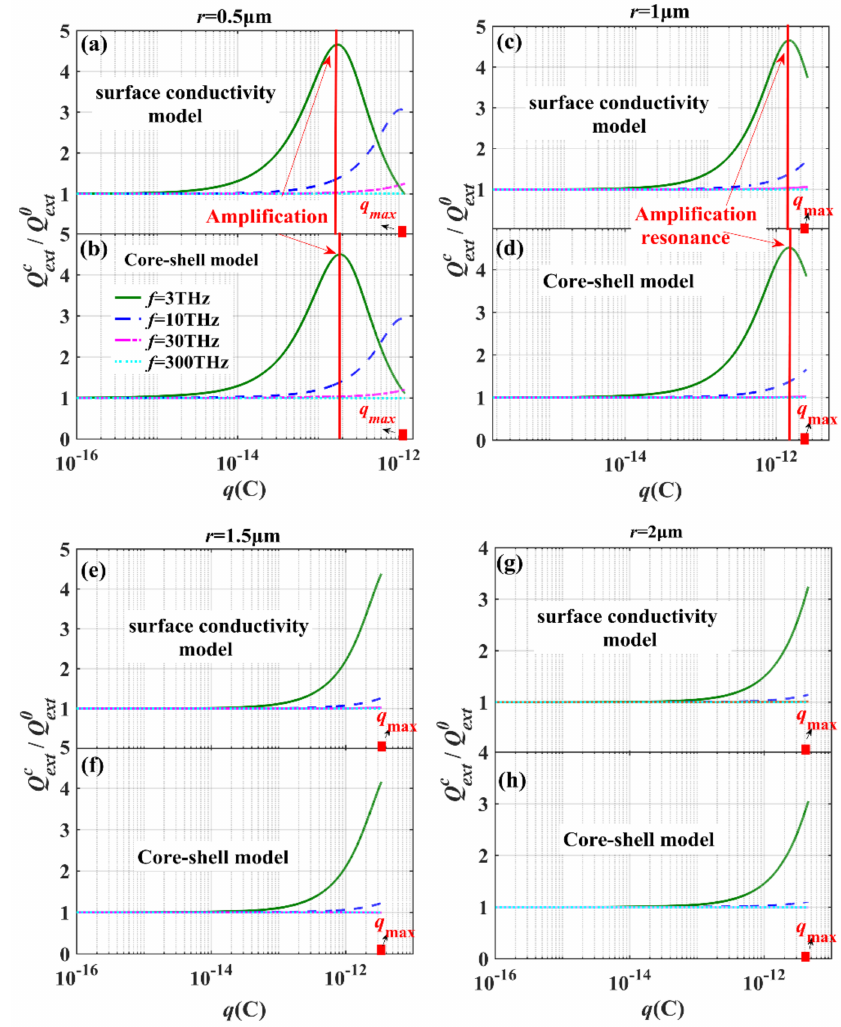
Figure 3. The extinction amplification factor (i.e., Q c frequencies 3 THz, 10 THz, 30 THz, and 300 THz, and its dependence on q , the total net charge of the Martian dust particle. ( a , c , e , g ) are given by the surface conductivity model, while ( b , d , f , h ) are given by the Core-shell model for r = 0.5 µ m, 1.0 µ m, 1.5 µ m and 2.0 µ m,